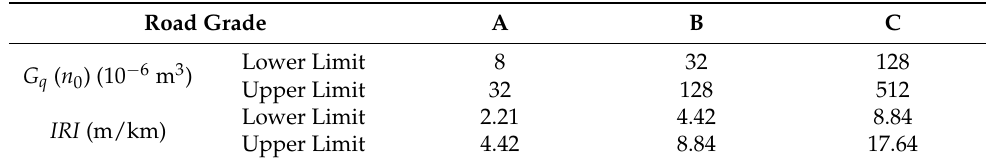
Table 3. The corresponding relationship between road grade, PSD , and IRI .